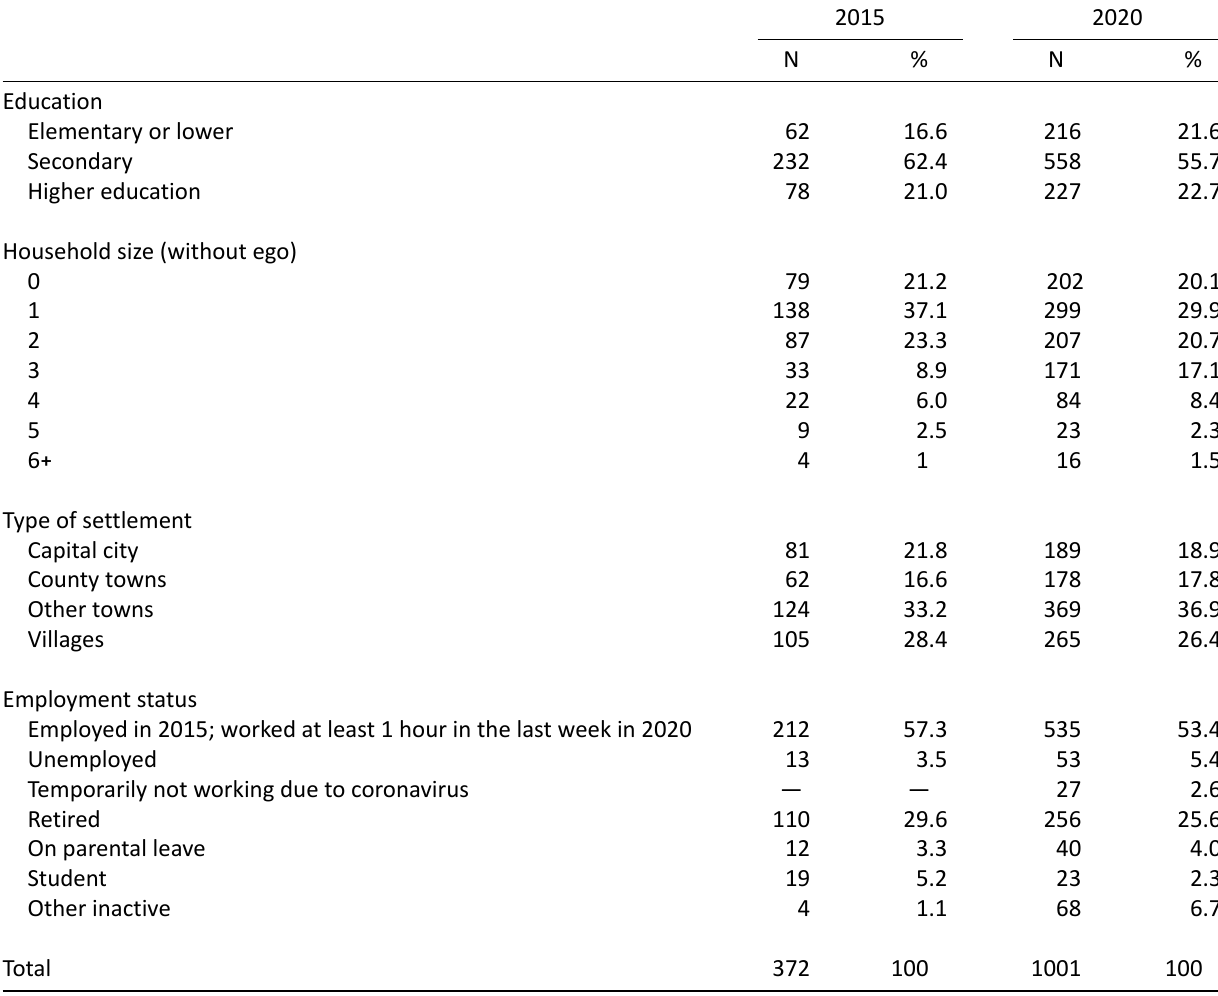
Table 2. Socio‐demographic characteristics of